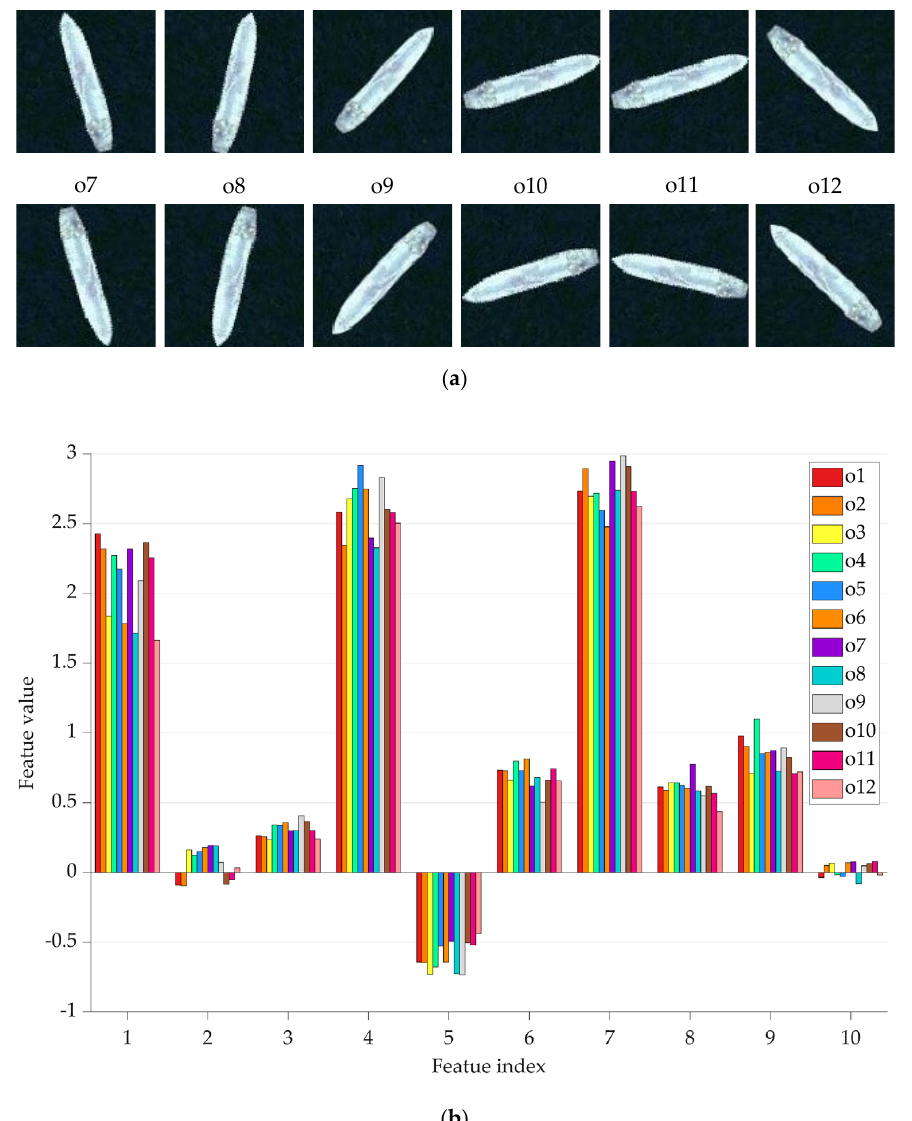
Figure 15. Rotation-invariant channel features based on Fourier HOG. ( a ) Display of testing candidate ships in the 12 directions. ( b ) Visualization of the Fourier HOG in the corresponding direction. Note that the feature vectors here only take ten dimensions, and each group is composed of twelve eigenvalues, which ideally should be the same.